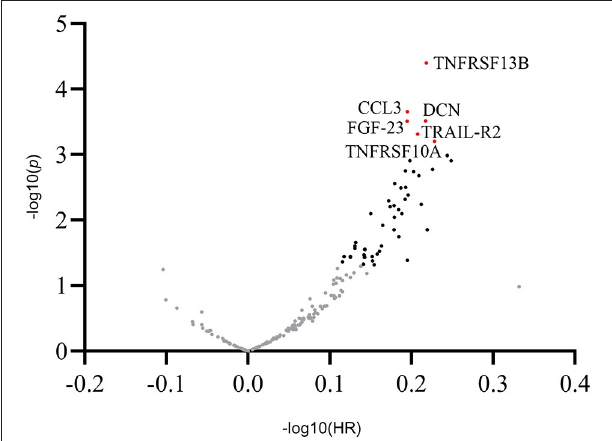
FIGURE 1 | Overview of the hazard ratios of all proteins. Volcano plot showing log hazard ratios and p -values of plasma proteins for major adverse cardiovascular events in patients with stable coronary artery disease. Proteins associated with adverse outcomes at a level of significance of 0.05 are presented as black dots. Proteins with a statistically significant association with outcomes after adjusting for multiple comparisons ( p < 0.001) are presented as labeled red dots. CCL3, C-C motif chemokine 3; DCN, decorin; FGF-23, fibroblast growth factor 23; TNFRSF13B, tumor necrosis factor receptor superfamily member 13B; TNFRSF10A, tumor necrosis factor receptor superfamily member 10A; TRAIL-R2, tumor necrosis factor-related apoptosis-inducing ligand receptor